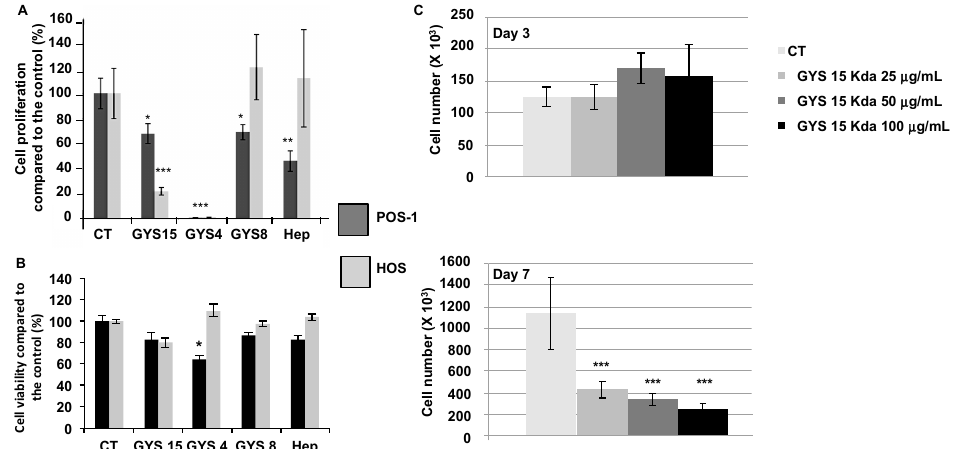
Figure 1. Comparison of the effects of OS-EPS derivatives with various molecular weights on two osteosarcoma cell lines, the mouse POS-1 and human HOS: ( A ) proliferation of both cell lines after seven days of treatment; ( B ) cell viability assessment of HOS and POS-1 cells after three days of treatment with or without OS-EPS derivative treatment; and ( C ) kinetic of biological activity of increasing doses of GYS15 on HOS cell proliferation. Proliferation assays were performed by cell counting with Trypan Blue to compare the cell proliferation rate between groups. OS-EPS 15 kDa (GYS15), OS-EPS 8 kDa (GYS8), OS-EPS 4 kDa (GYS4), heparin (Hep) and control (CT). * p < 0.05; ** p < 0.01; *** p < 0.001.